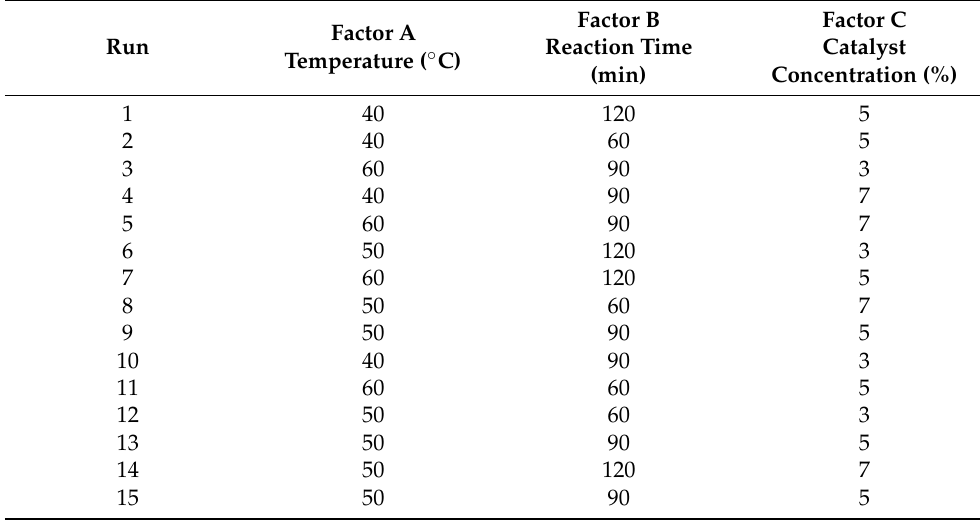
Table 2. Design of the Randomized Response Model.